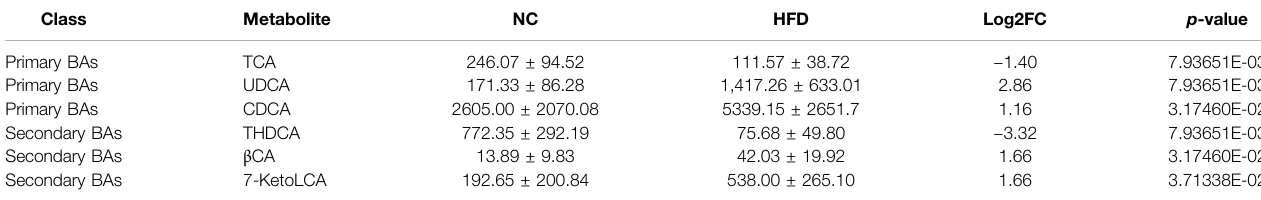
TABLE 3 | Differential bile acids between normal groups and high-fat diet groups.